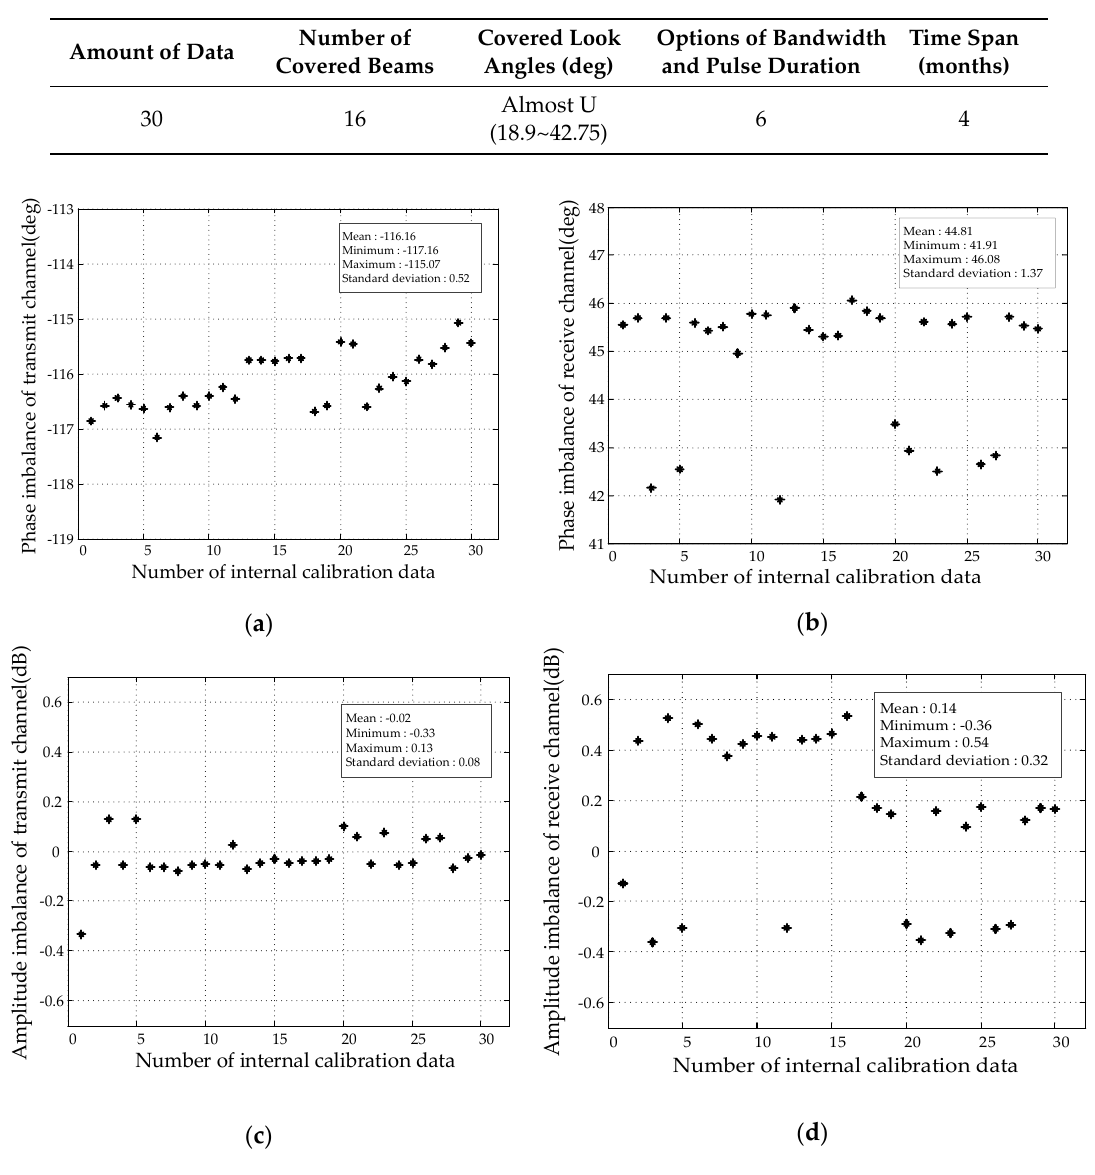
Table 2. Data information for the real situation analysis of channel imbalances, where U means uniform distribution.